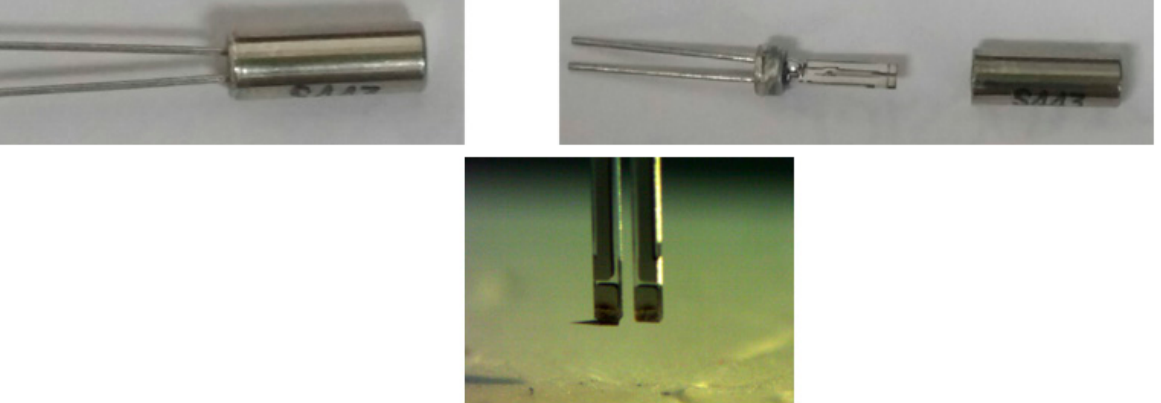
Figure 12. Canister removal and tungsten tip attachment to QTF.